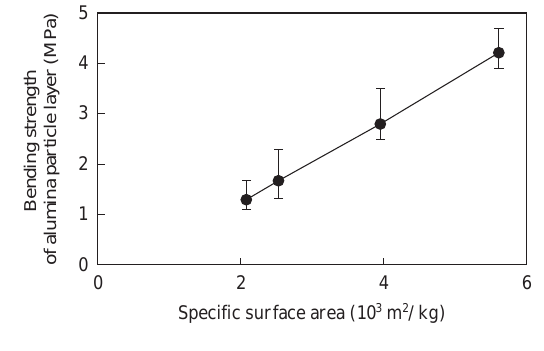
Bending strength of ground alumina particle layer after heat treatment at 827K as a function of specific